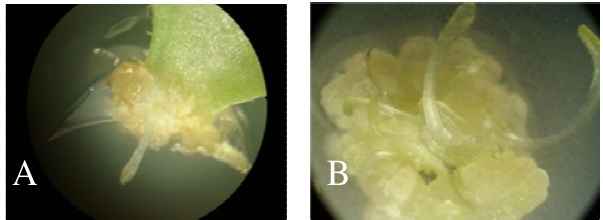
Fig. 1. Morphologically different calli induced by different combinations of growth regulators and carbon sources; A) friable callus in the medium containing 2 mg/L BAP + 0.1 mg/L NAA; B) compact callus in the medium containing 0.5 mg/L BAP